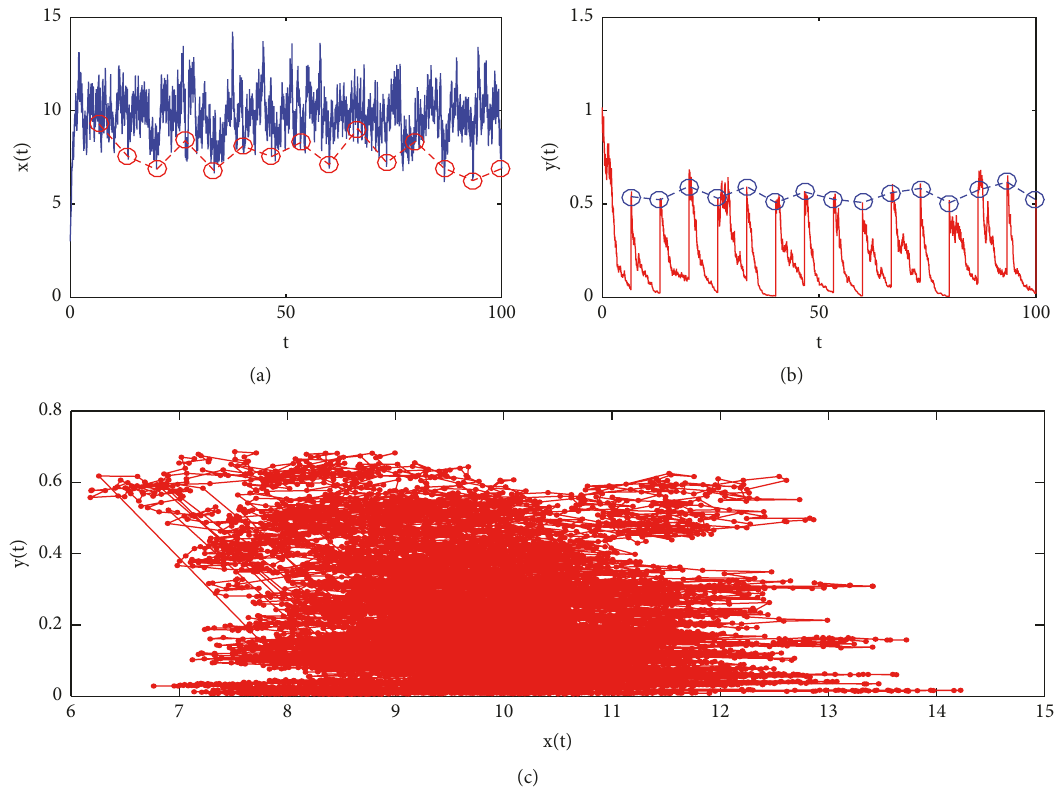
Figure 2: Solutions of model (2) with 𝛼 1 = 0.15,𝛼 2 = 0.25 . The other parameters are identified with Figure 1.